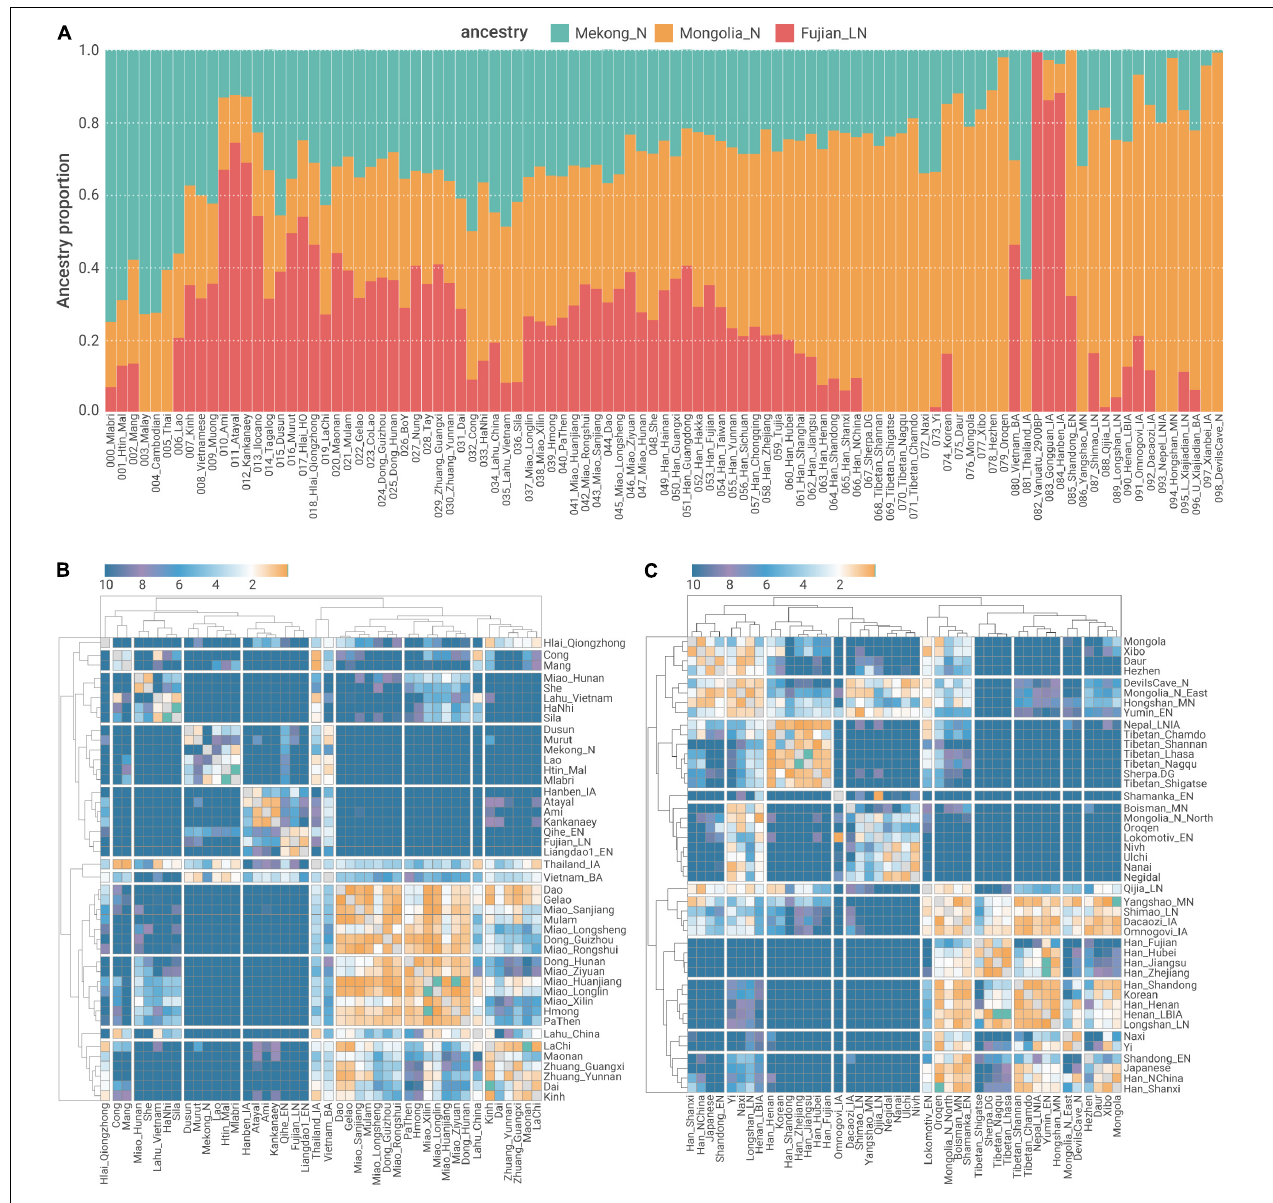
FIGURE 5 | qpAdm and qpWave modeling of population structure in relation to out-groups (A) admixture proportion estimates of three ancestries related to Mongolia_N, Fujian_LN, and Mekong_N. (B,C) Pairwise qpWave negative log p -values (-log 10 p ) for (B) Southeast Asians, (C) Northeast Asians, and Han